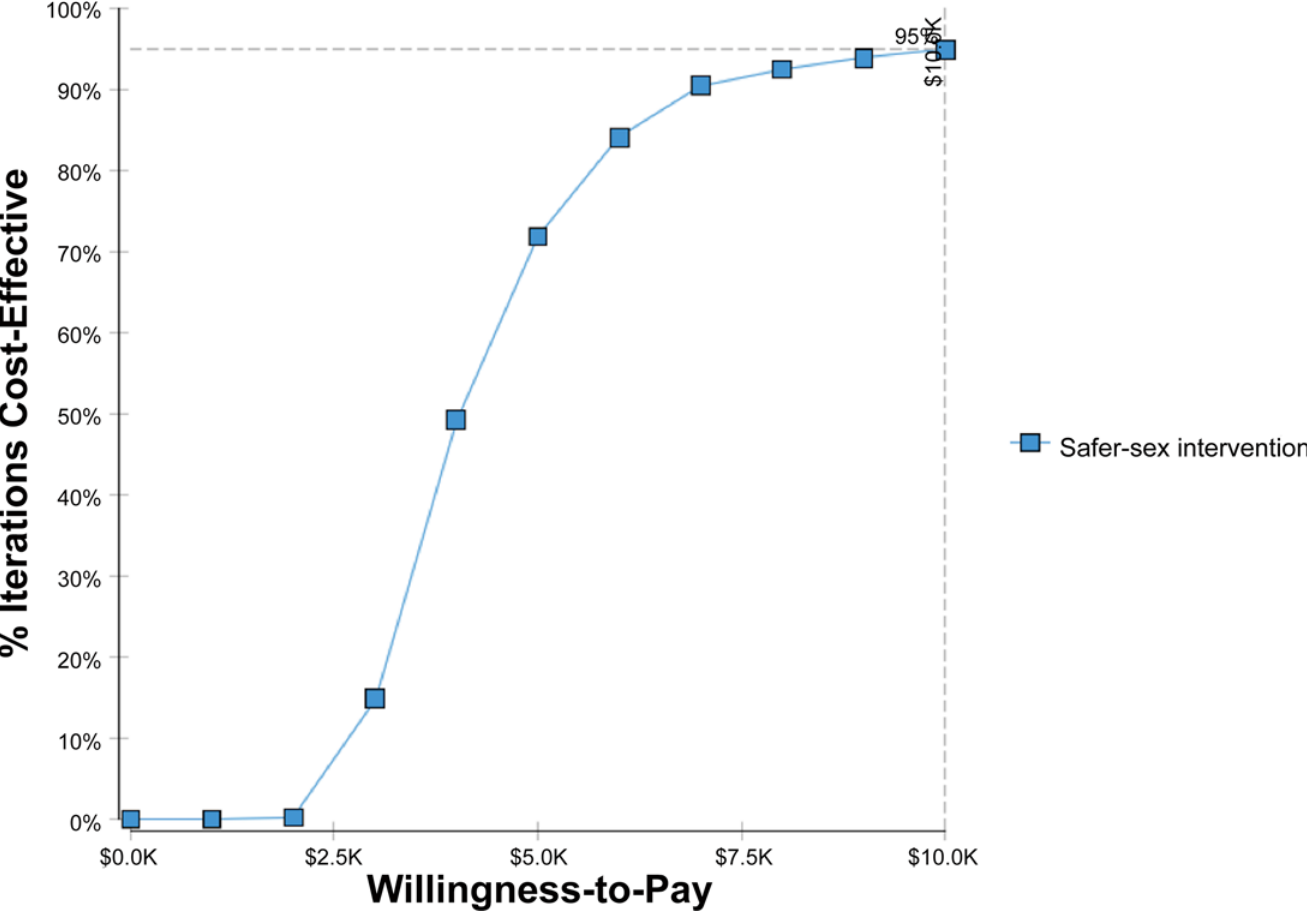
Fig 2. Cost-effectiveness acceptability curve for the combined interactive safer sex/ didactic safer injection intervention in Cd. Juarez.